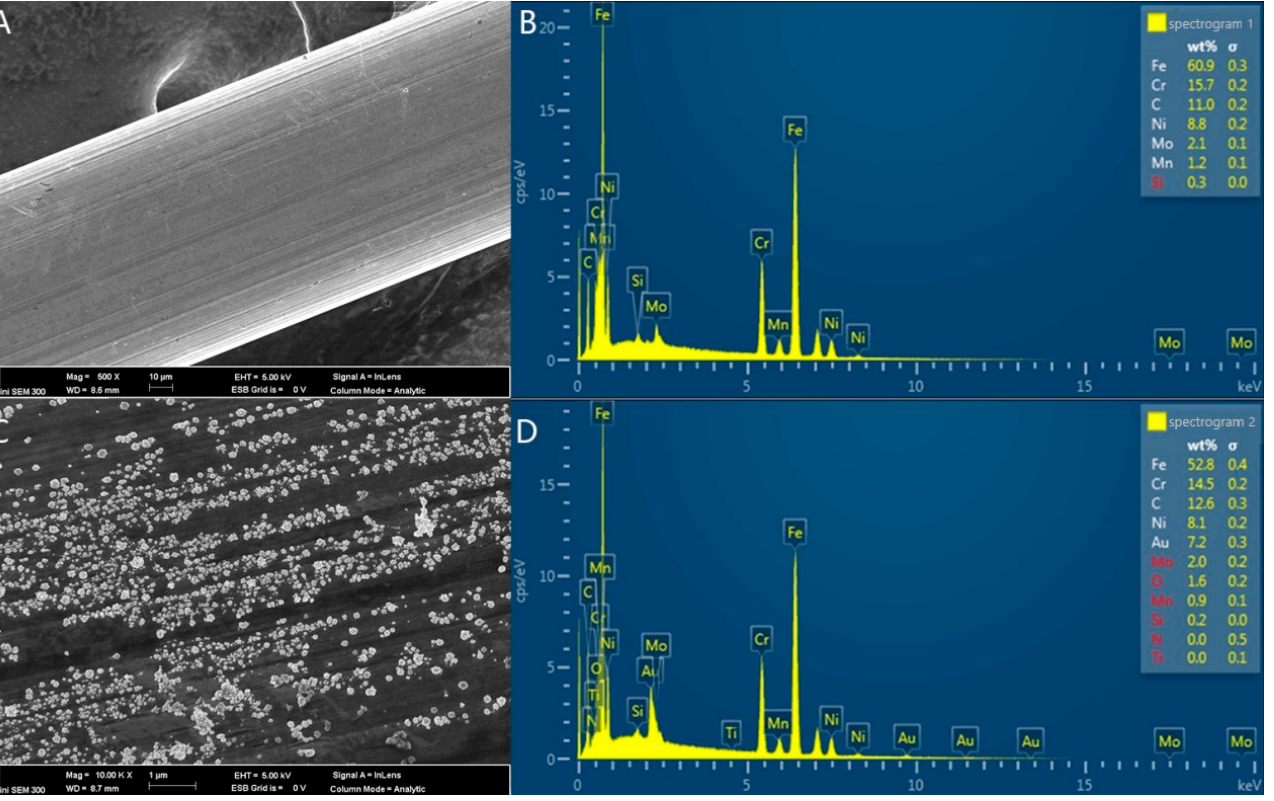
Figure 1. The SEM ( A , C ) and EDS ( B , D ) spectrum analysis of bare SS and Au/SS electrode. 3.2. The Electrochemical Performance of the Au/SSWire-Based Electrochemical Microsensor 3.2. The Electrochemical Performance of the Au/SSWire-Based Electrochemical